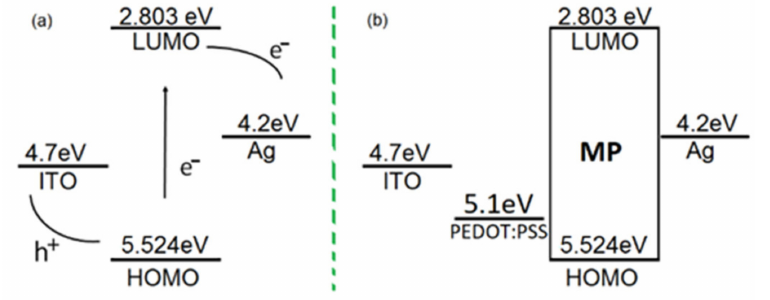
Figure 5. Schematic energy level diagram of the device ( a ) ITO/MP/Ag and ( b ) ITO/PEDOT:PSS/MP/Ag.